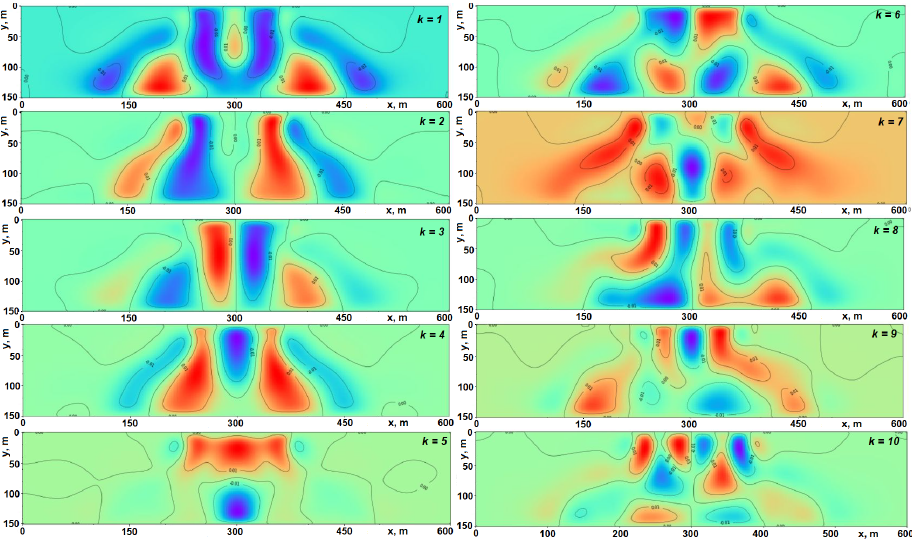
Figure 12. The first 10 principal components at t = 10